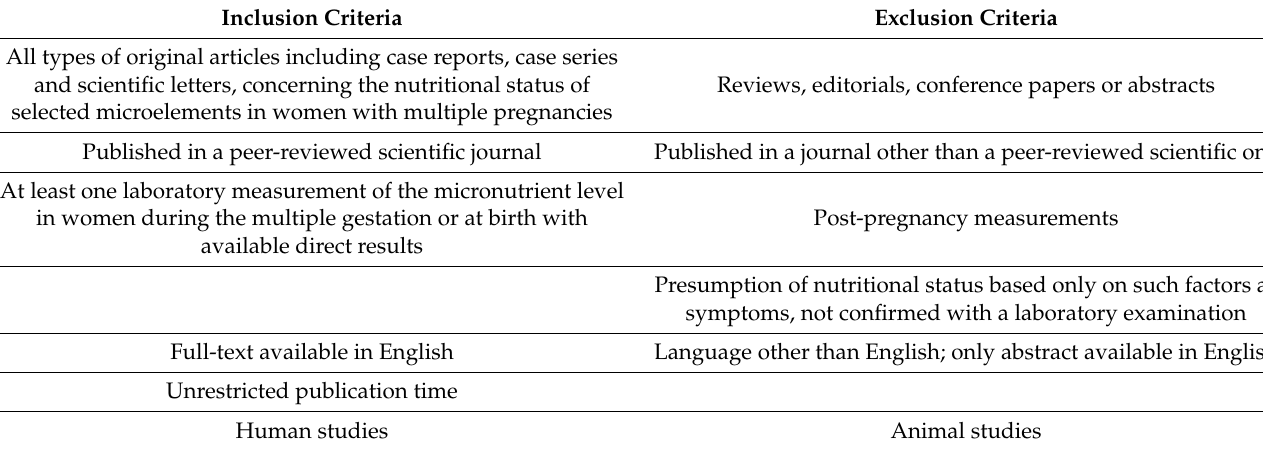
Table 2. Inclusion and exclusion criteria for retrieved